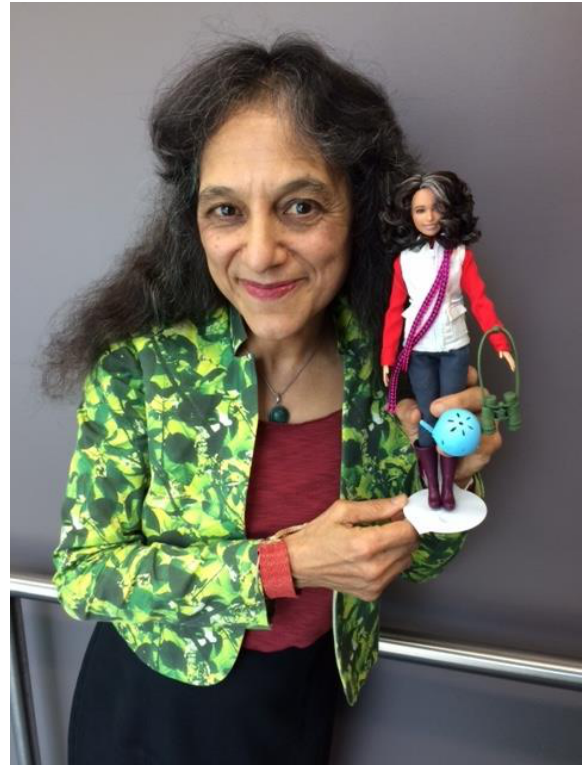
Figure 4. Nalini Nadkarni showing the “TreeTop Barbie” that the Mattel corporation and the Na- tional Geographic Society created to inspire young children to explore nature and contribute to and appreciate science. Photo credit: Hayley Jackson.